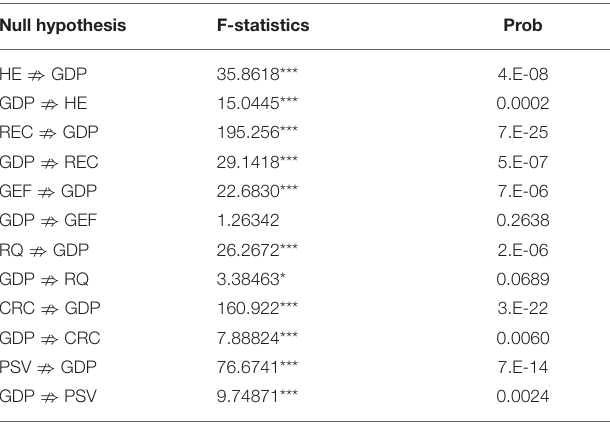
TABLE 8 | Pairwise granger causality